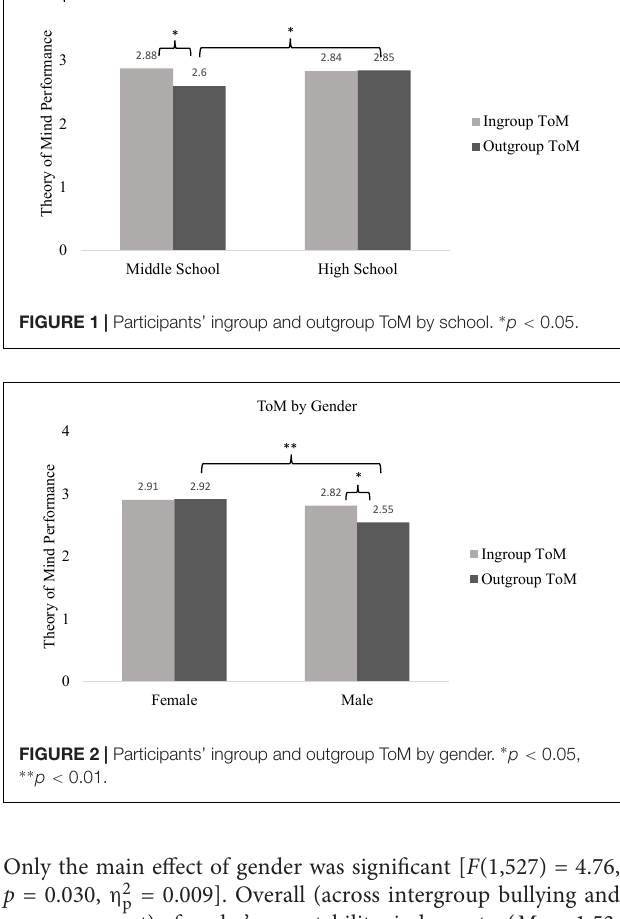
Only the main effect of gender was significant [ F (1,527) =